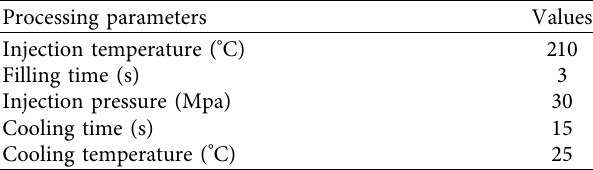
Table 1: Processing parameters of ABS in injection molding. Processing parameters